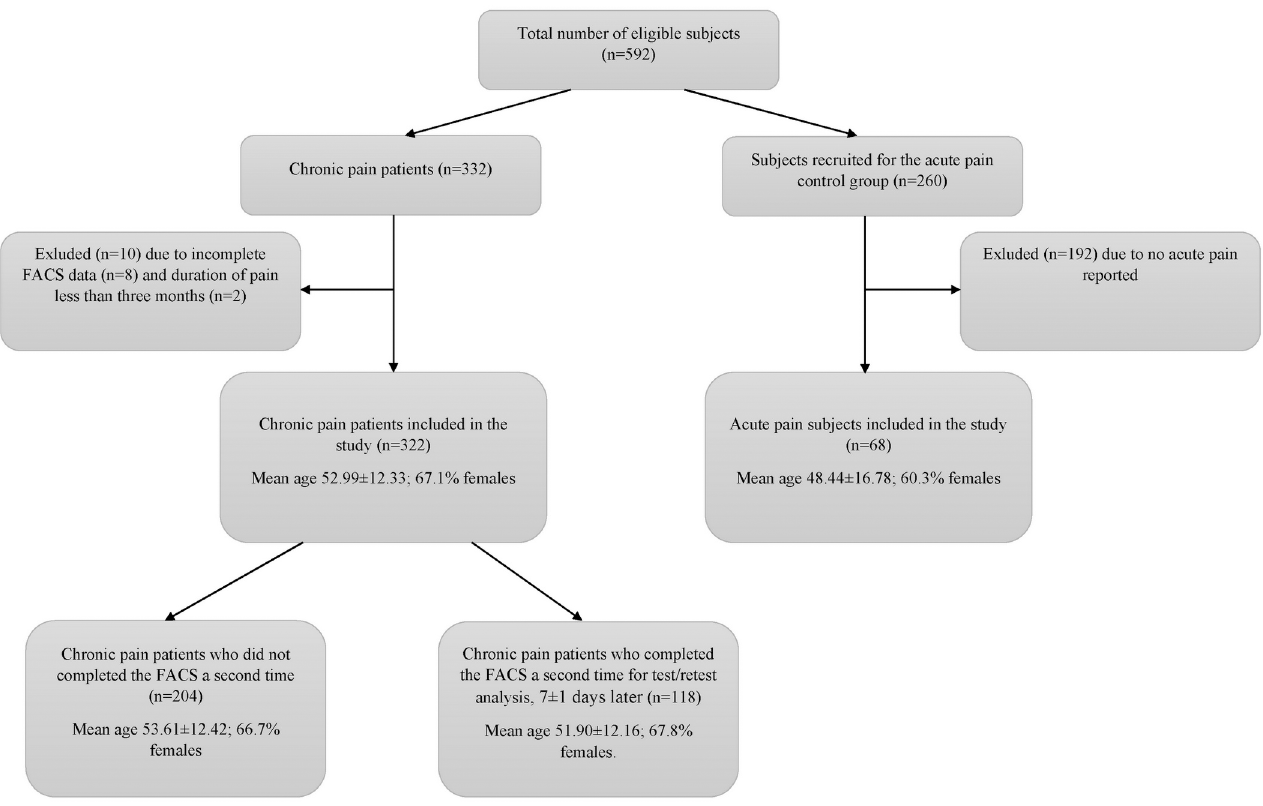
Fig 1. Flowchart of